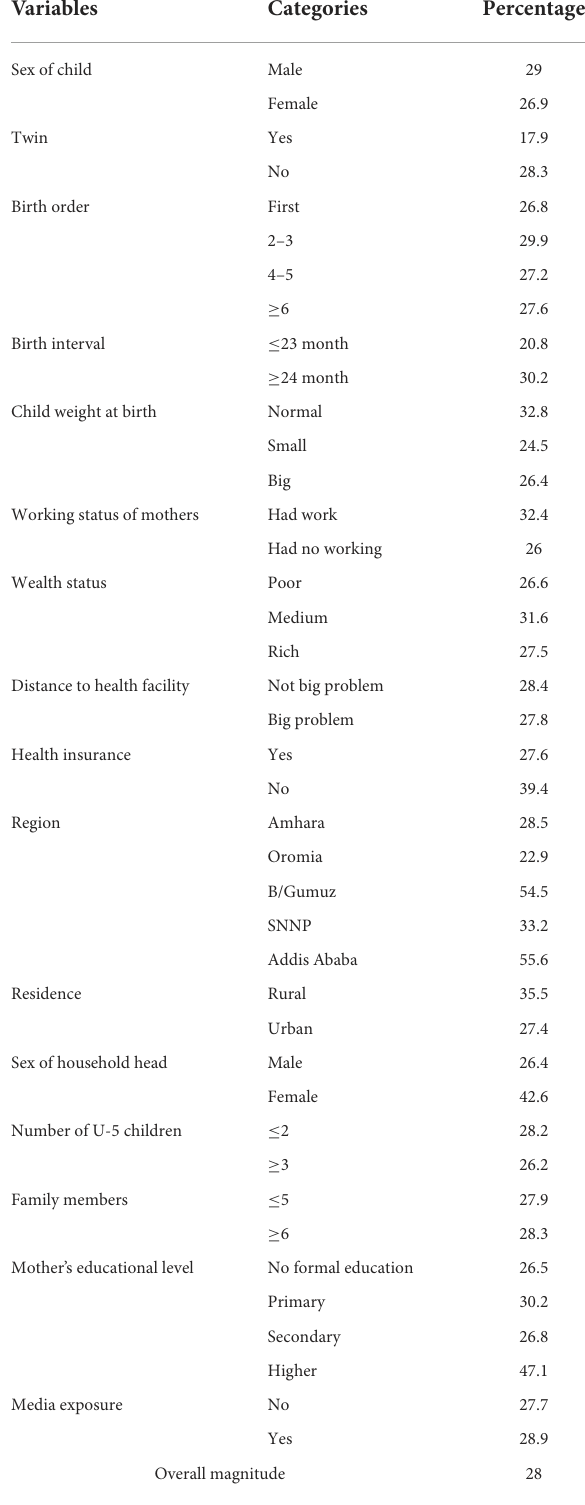
TABLE 2 The magnitude of ORS utilization based on different characteristics among under five children in diarrhea hotspot regions of Ethiopia in